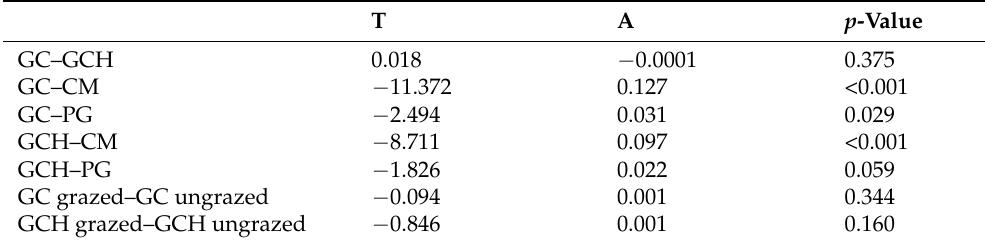
Table 2. Results of the multi-response permutation procedure (MRPP) for carabid assemblages in early summer. T is the test statistic calculating the difference between observed and expected delta, while A is the chance-corrected within-group agreement.